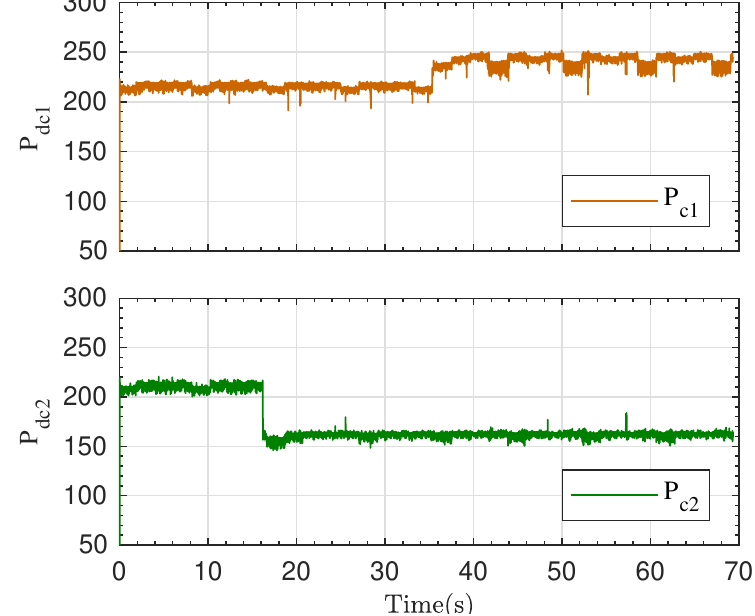
Figure 16. Experimental dynamic operation of DC power under unbalanced power per string due to solar irradiation and temperature